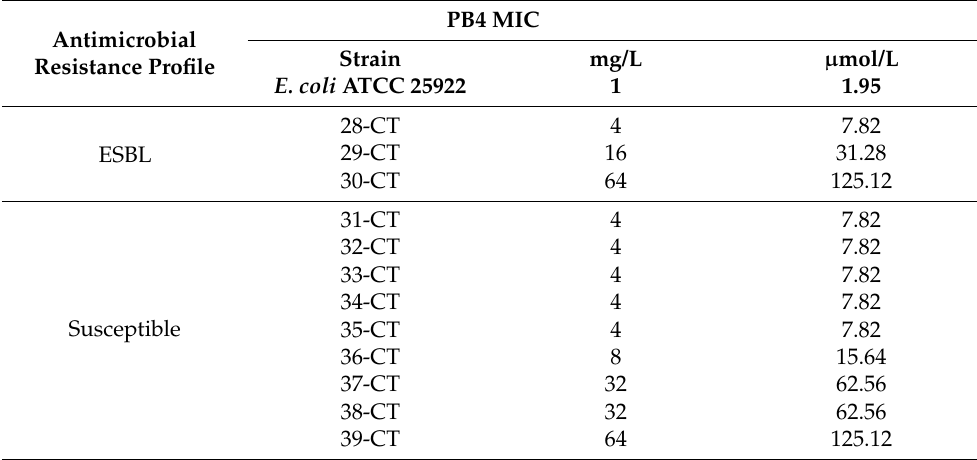
Table 3. Activity of PB4 on E. coli ATCC 25922 control strain and on 12 E. coli clinical strains (ESBL and susceptible).